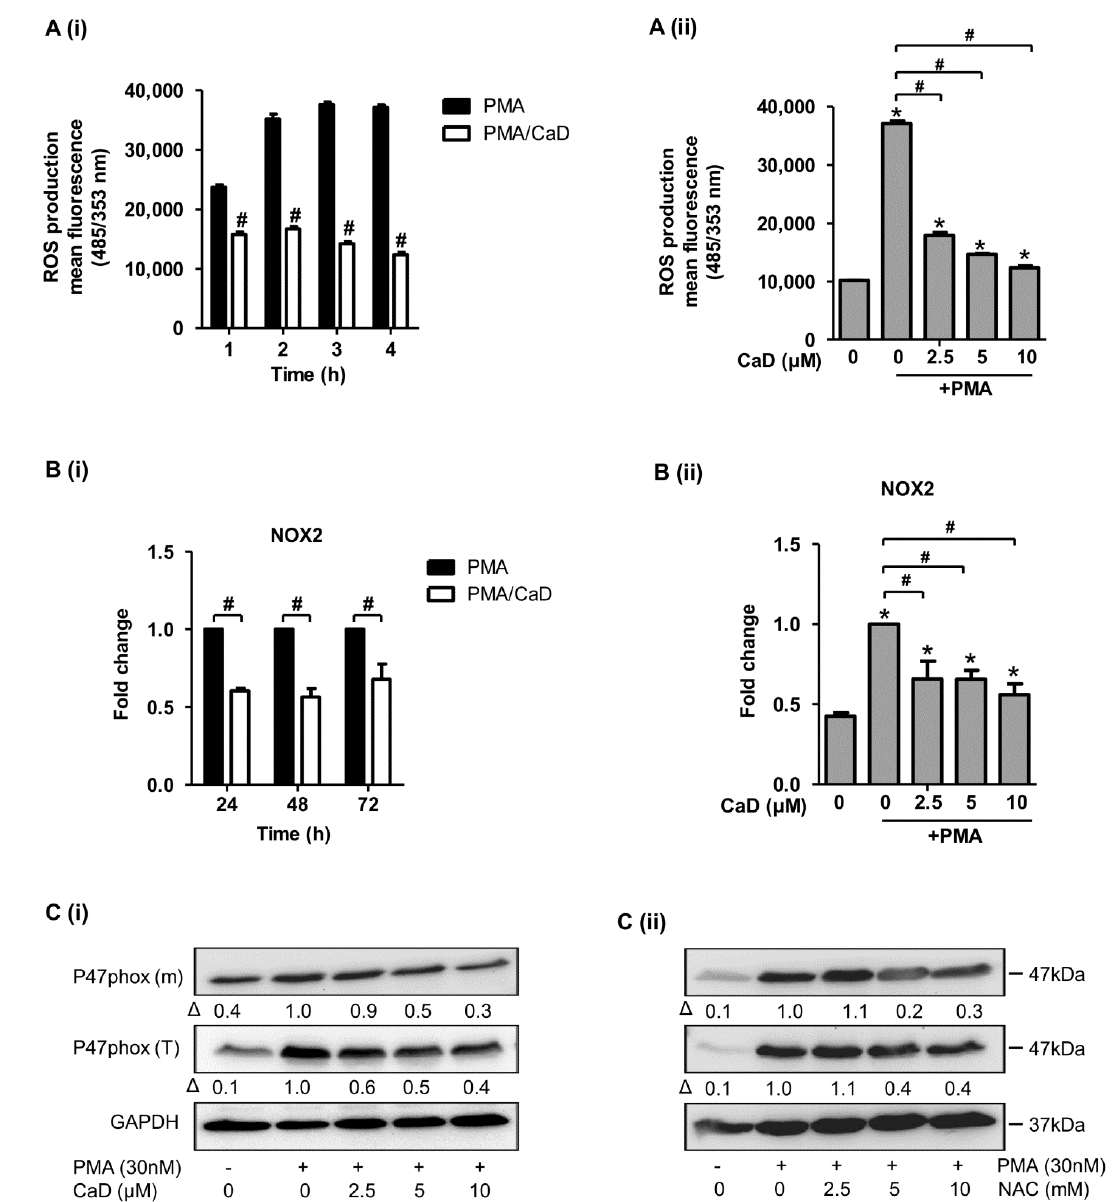
Figure 9. CaD modulates the ROS-NADPH oxidase pathway during monocyte-to-macrophage differentiation and in- flammation. THP-1 monocytes were pretreated with CaD (10 µ mol/L), or various concentrations (0–10 µ mol/L) of CaD/N-acetylcysteine (NAC) for 1 h, followed by PMA (30 nmol/L) treatment for various time points ( Ai , Bi ), for 4 h ( Aii ), or 24 h ( Bii , C ). ROS production ( A ) was measured using the cell-permeable indicator H 2 DCF-DA as described in the Materials and Methods section. NOX2 transcript levels ( B ) were measured by quantitative RT-PCR, and total p47phox protein expression (T) and membrane translocation (m) ( C ) were measured by Western blotting. ∆ , fold-change normalized to PMA only ( n = 3, mean ± SEM. * p < 0.05 vs. no treatment, # p < 0.05 vs. PMA only, Student’s t -test ( Ai , Bi ), or one-way ANOVA ( Aii , Bii ). The Western blots represent one from at least three independent